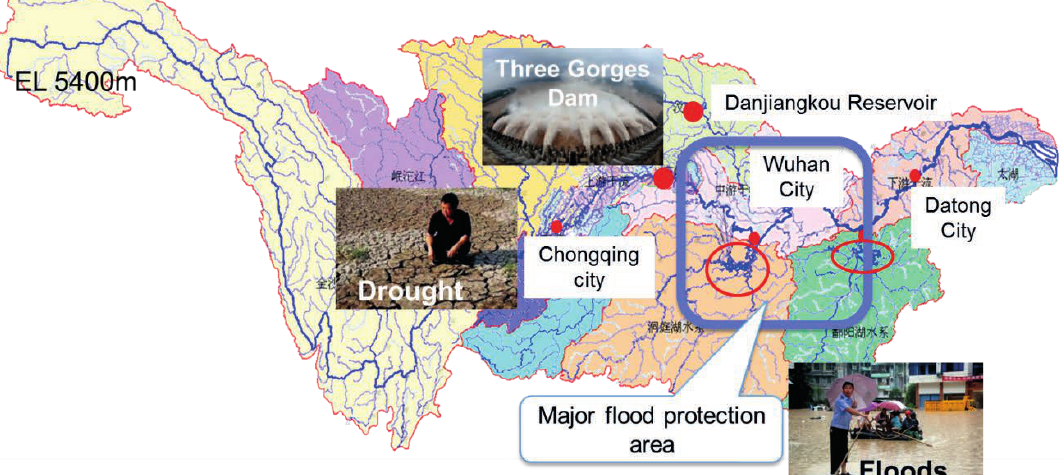
Fig. 1 Changjiang River basin. Water issues are droughts and floods in the upper reach; floods in the middle reach due to its low elevation and the sudden change from mountain areas to flood plains; and floods and navigation issues in the lower